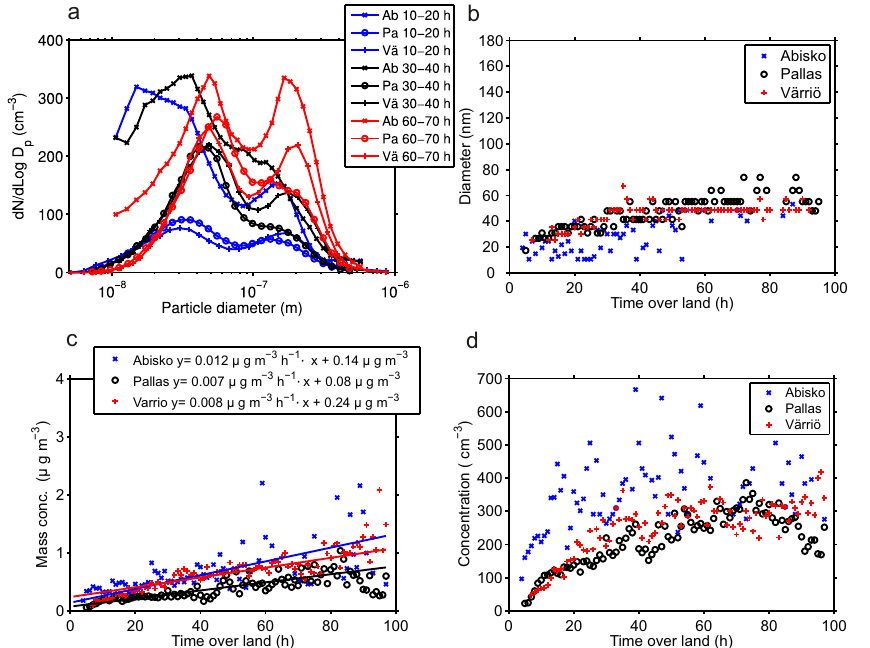
Fig. 8. (a) Mean particle number size distributions for certain overland time periods for all stations. Particle mode diameter (b) , integrated mass concentration (c) , number concentration (d) as a function of time the corresponding air mass has spent over land. In all subplots, only the winter period (1.10–31.3) is